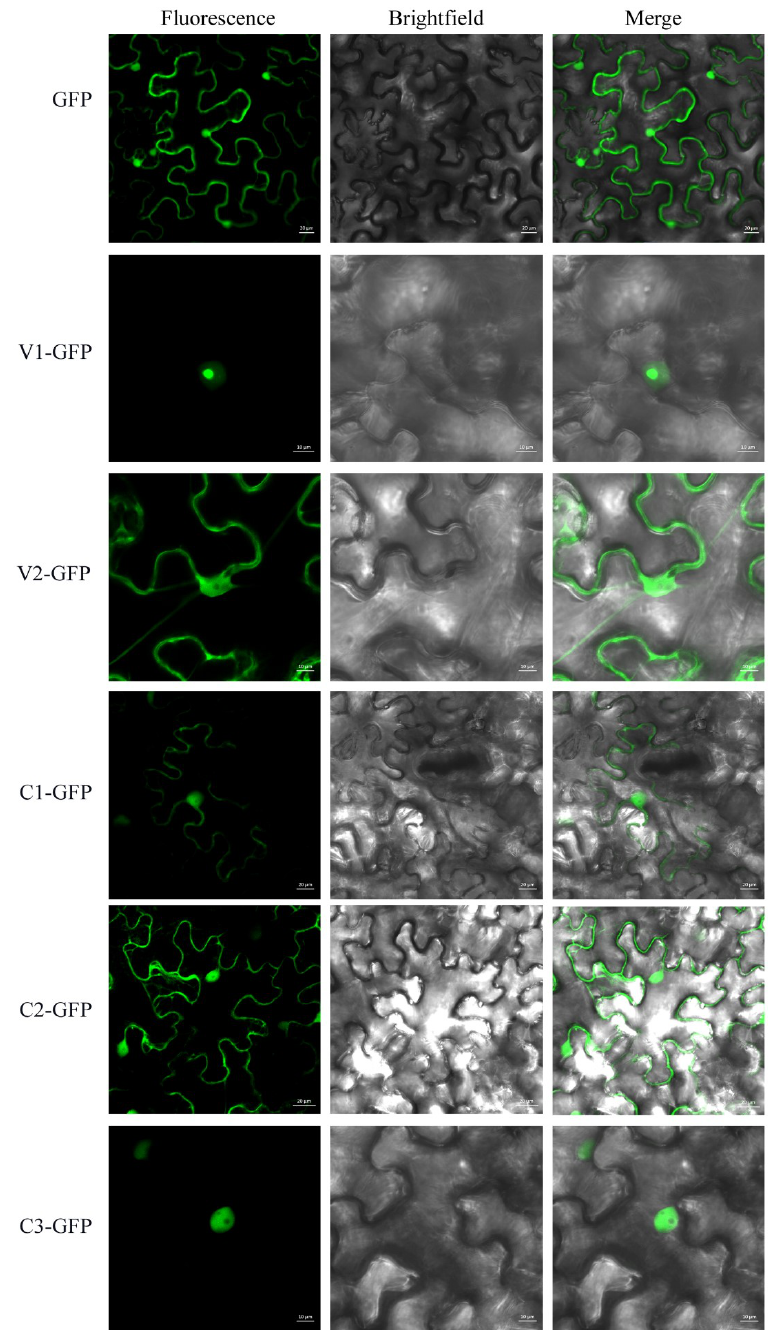
Figure 1. Subcellular localization of AGV V1, V2, C1, C2, and C3 in N. benthamiana leaves. The GFP expressed from pCam35S-GFP is distributed evenly in the cytoplasm and nucleus. The V1-GFP fusion protein from pCam35S-V1-GFP is localized to the nucleus especially the nucleolus in the infiltrated leaves of N. benthamiana . The V2-GFP from pCam35S-V2-GFP and C1-GFP from pCam35S-C1-GFP are distributed in the cell cytoplasm and nucleus, without nucleolus accumulation. The localization of C2-GFP from pCam35S-C2-GFP is mainly in the nucleus with bits of fluorescence in the cytoplasm. The subcellular localization of C3-GFP from pCam35S-C3-GFP is targeted to the nucleus but not to the nucleolus. Confocal laser scanning images were taken approximately 3 d post infiltration. Scale bars indicated in the photos represent 10 or 20 μm.